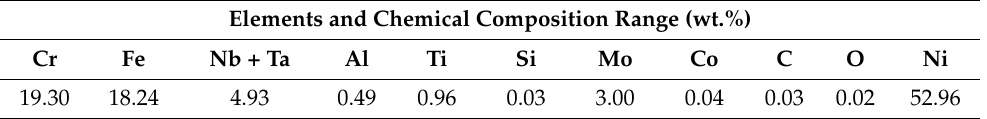
Table 1. Chemical composition of IN718 powder used in SLM process (certificate for batch PR100026, Carpenter